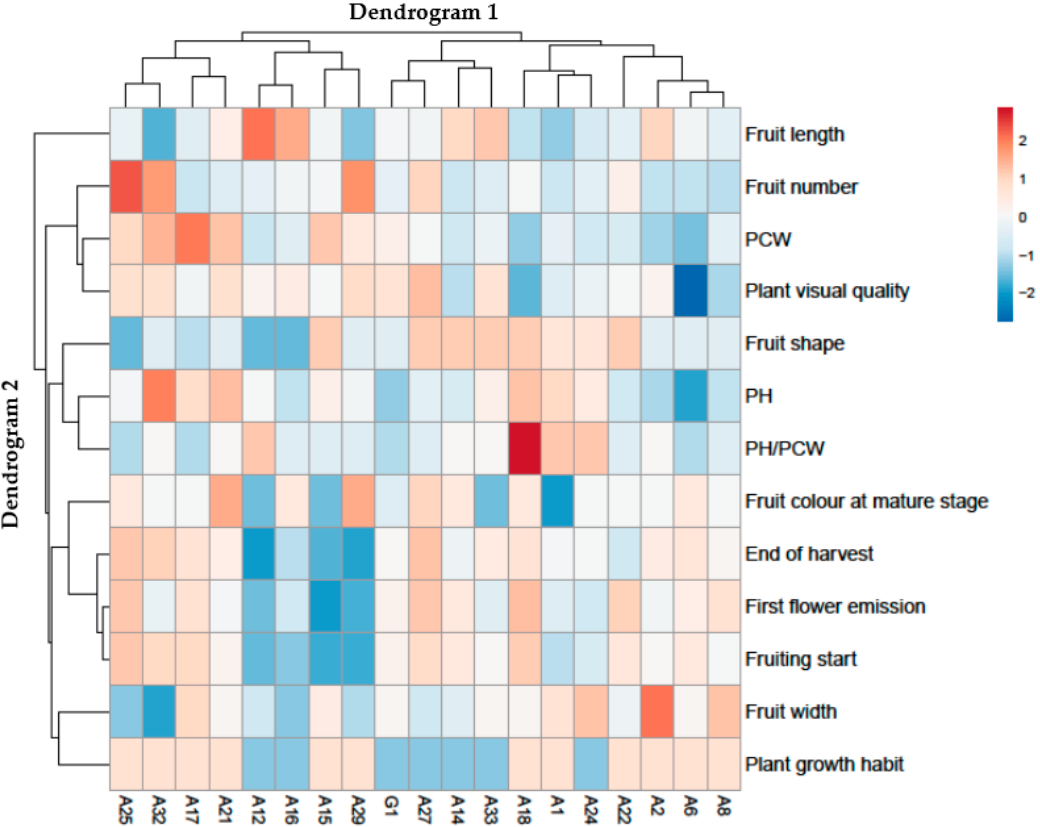
Figure 1. Cluster heat map analysis summarizing two-year (2016 and 2017) Sicilian chili pepper accessions’ responses to agro-morphological characterization by using IPGR (International Plant Genetic Resources Institute) descriptors. The figure was created utilizing the https://biit.cs.ut.ee/clustvis/ online program package with Euclidean distance as the similarity measure and hierarchical clustering with complete linkage. PH: plant height; PCW: plant canopy width.